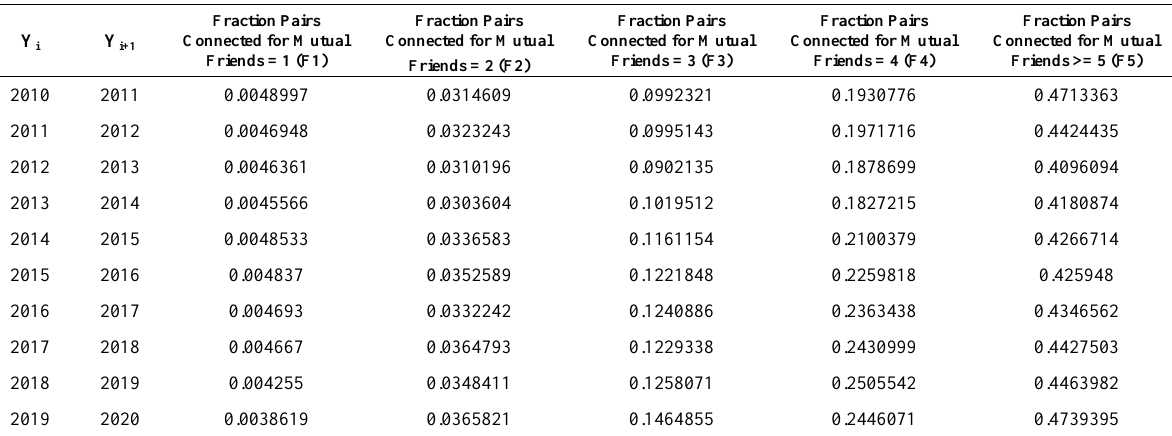
Table 4. Shared Affiliation Bias Evaluation in